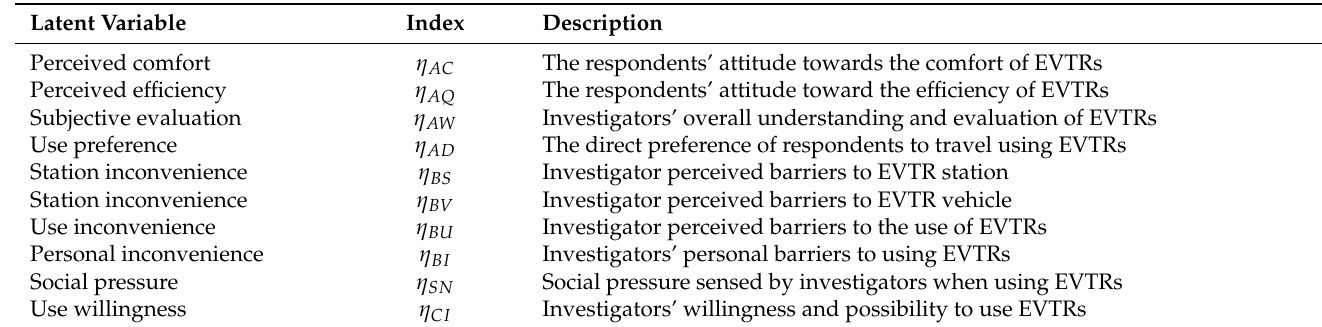
Table 1. Description of attitudinal